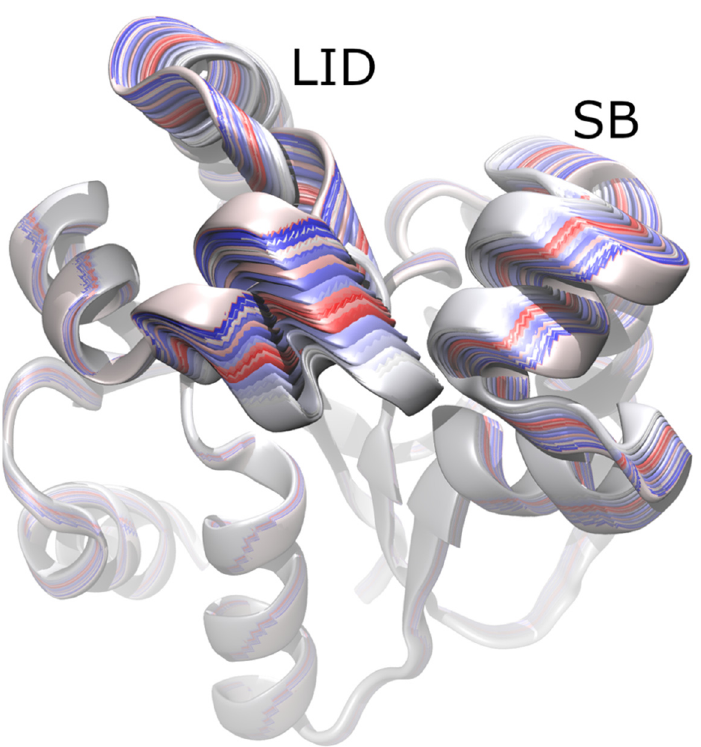
Figure 4. Trajectory projected on the first principal component showing the opening and closing motion of the LID and SB domains.